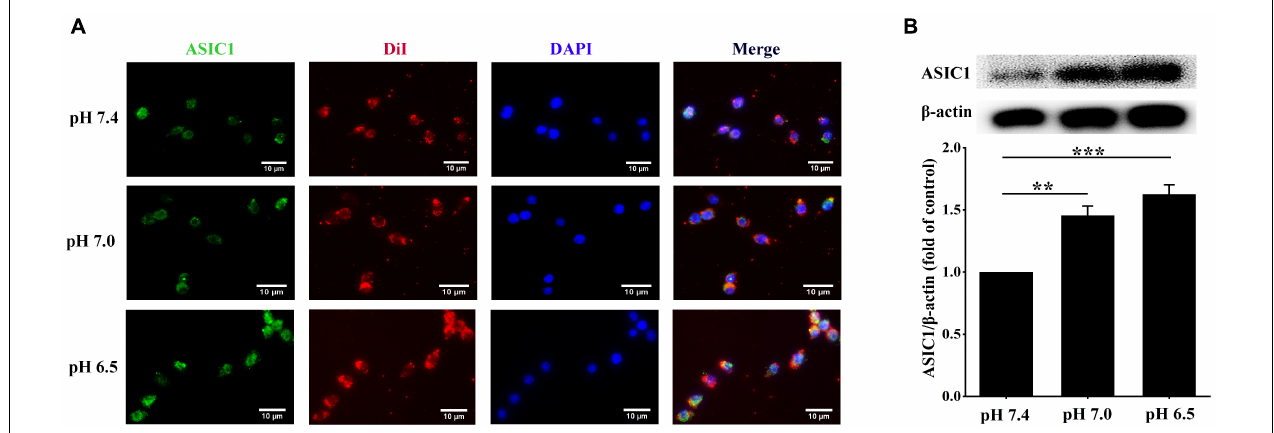
FIGURE 2 | Extracellular acidification promotes acid-sensing ion channel 1 (ASIC1) expression and translocation in macrophages. RAW 264.7 macrophages were incubated with ox-LDL (25 µ g/ml) in different pH media for 24 h. (A) Representative immunofluorescence of ASIC1 and DiI in RAW 264.7 macrophages. The scale bar is 10 µ m. (B) The membrane protein levels of ASIC1 were measured using Western blot (WB) analysis. Data were shown as the mean ± SEM from 3 to 4 independent experiments. Statistical analysis was performed by one-way ANOVA. ** P < 0.01, *** P <